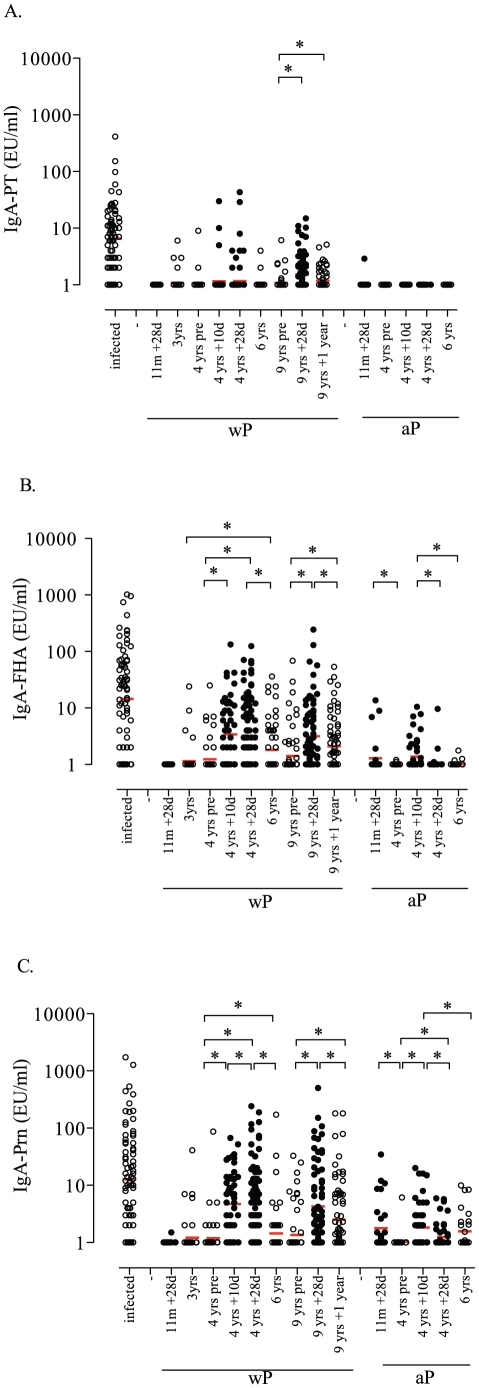
IgA levels.IgA responses specific for PT (A), FHA (B) and Prn (C) for each child in the on the x-axis presented group of children. The red horizontal bars indicate the GMC. The 10 and 28 days post-booster responses are indicated by the black circles and all other groups are indicate by open circles. * significant differences (p<0.05) are indicated for the healthy children between the presented age groups in similar primed children. Differences between infected children and the various groups of healthy wP and aP primed children are described in paragraph 3.1 of the results section.